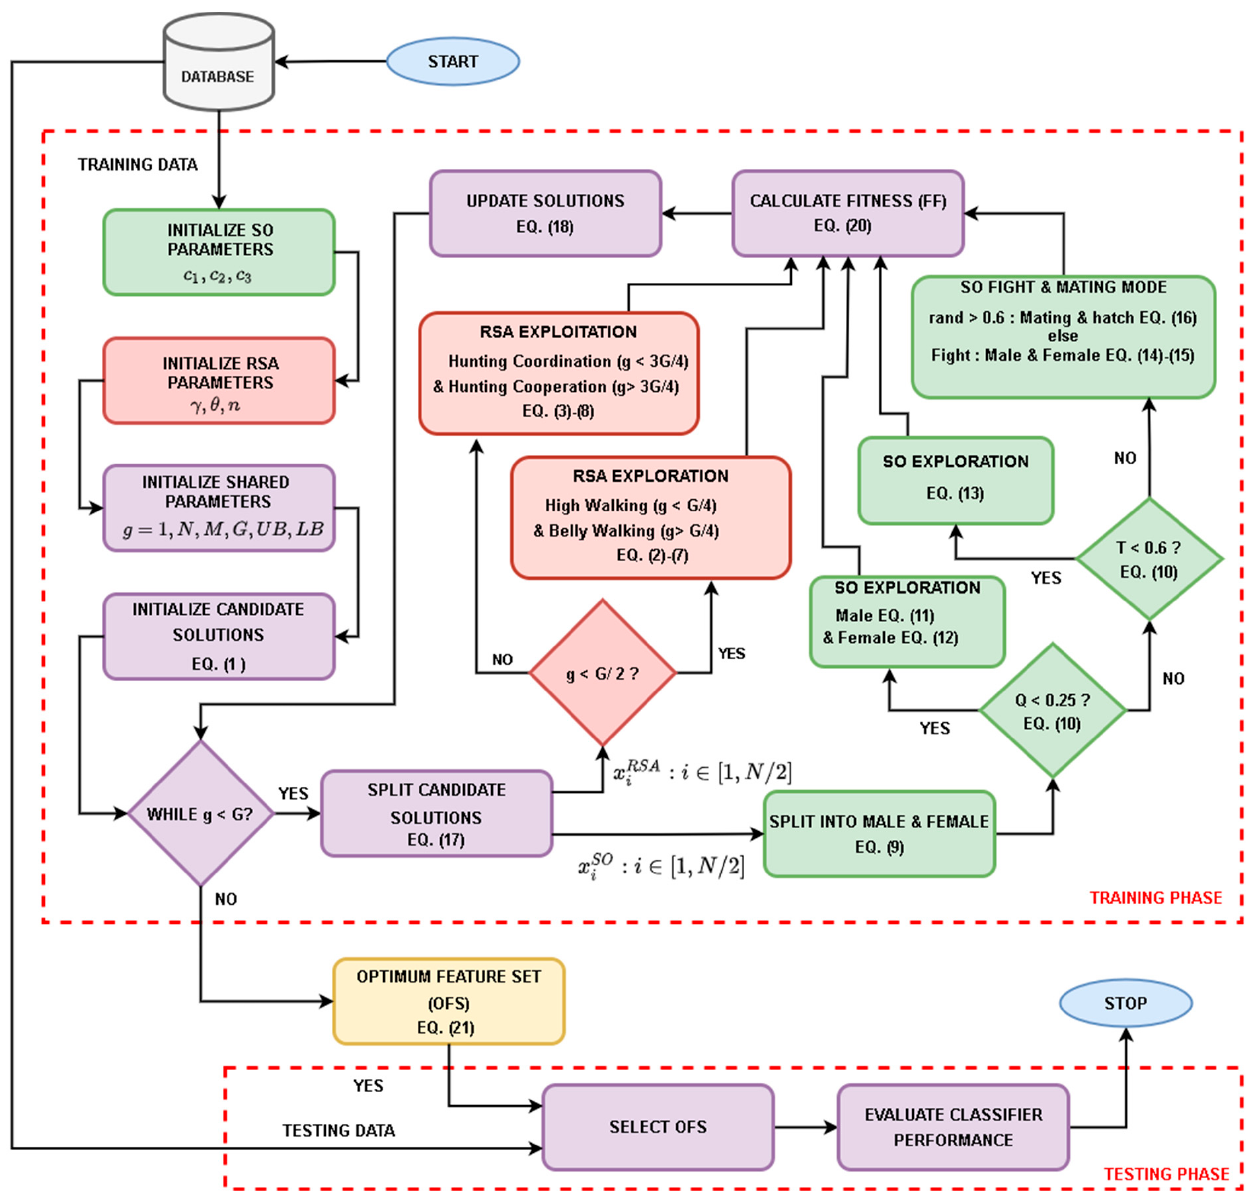
Figure 1. Structure of RSA ‐ SO